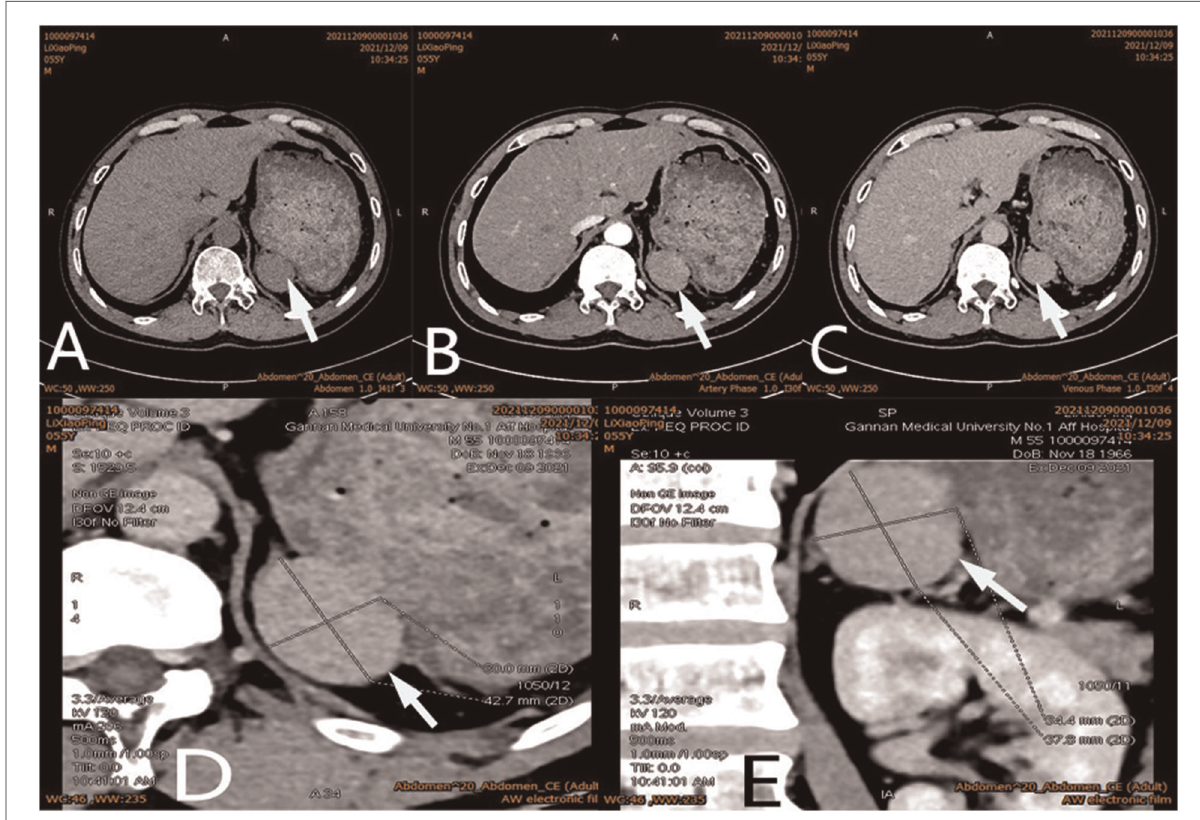
FIGURE 1 Ct scan of a mass (arrow) in the left adrenal region. The CT value of plain scanning which the internal density was heterogeneity ( A ), and enhanced scanning presented moderate enhancement ( B ), the delayed phase of the mass ( C ). Coronal image of the mass ( D ). Sagittal image of the mass ( E